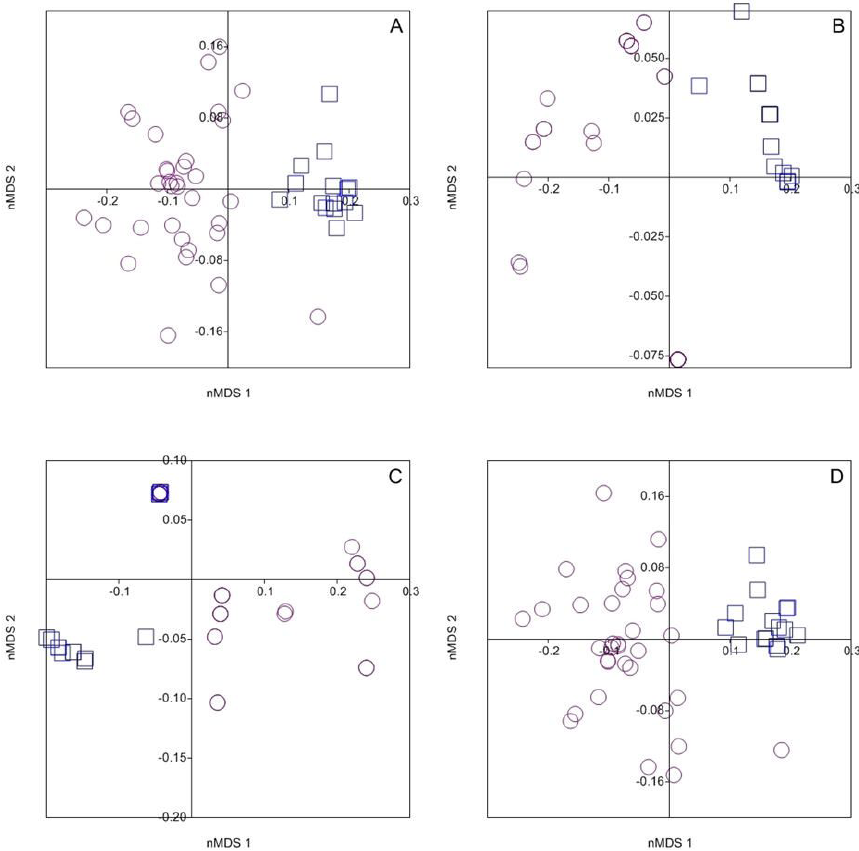
Figure 6. Non-metric multidimensional scaling analysis of diet items origin of P. squamosissimus in preserved area (circle) and impacted area (square). Item sources: animal (A), plant (B), autochthonous (C) and allochthonous